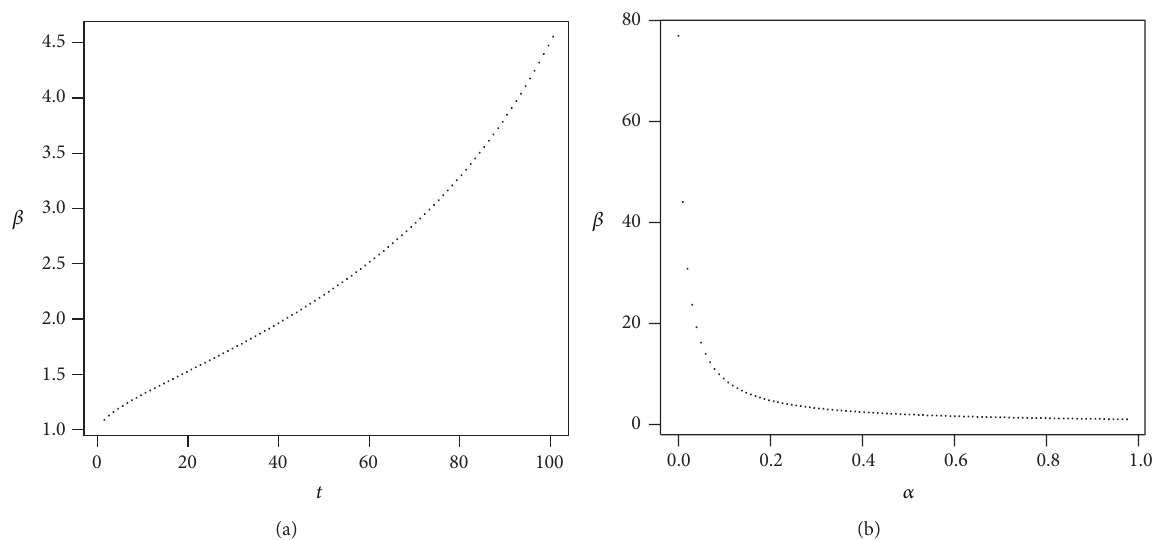
Figure 3: The plot shows 𝛽 as a function of 𝑡 (a) and 𝛼 (b) in our example. Parameters are 𝑟 = 4 %, 𝜇 = 8 %, 𝜎 = 20 %, ] = 0.1 %, 𝛾 = 10 %, and 𝛼 = 50 % (a) and 𝑡 = 40